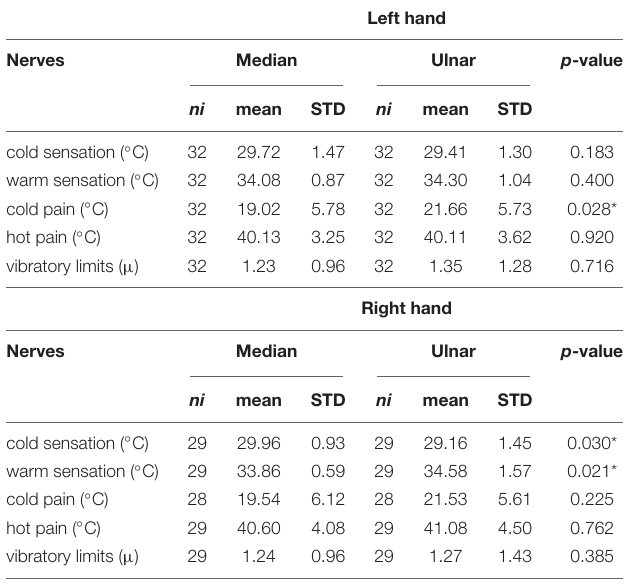
TABLE 3 | Mean QST parameters in the median and ulnar nerves on the left and right sides.